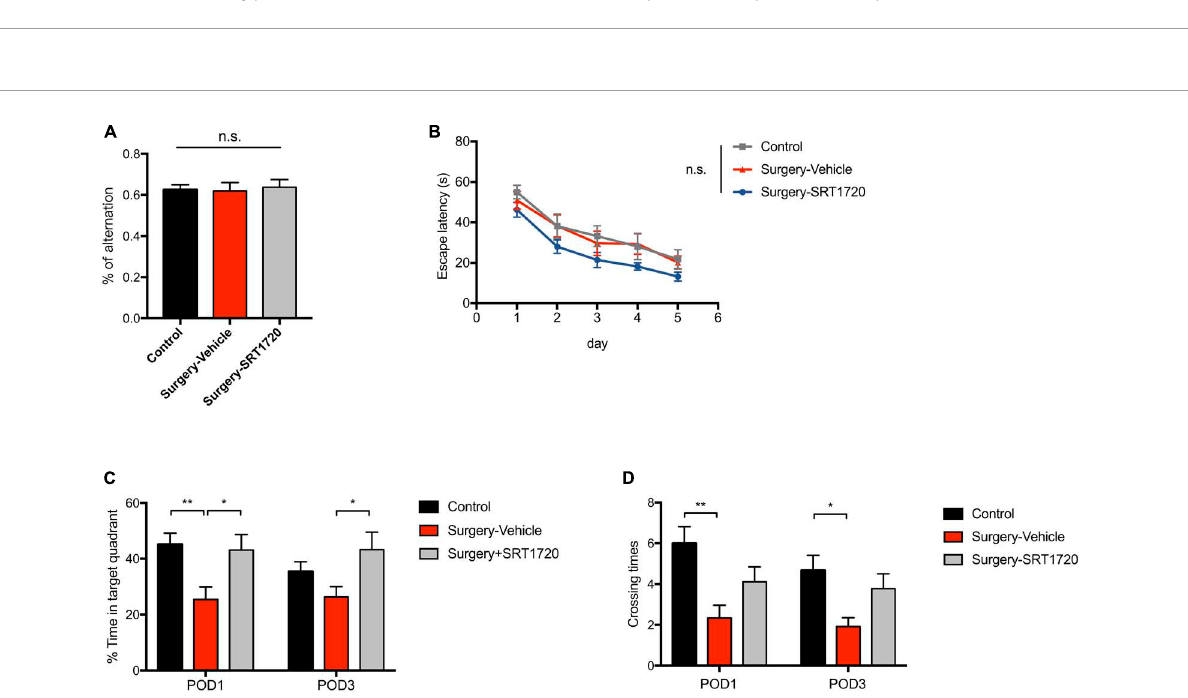
FIGURE7 SIRT1 activation overcomes loss of cognitive performance after surgery and anesthesia. (A) Y-maze performance on the third day after surgery. n = 11 for control, n = 6 for surgery-vehicle, n = 7 for surgery-SRT1720. One-way analysis of variance (ANOVA) with Tukey post-hoc test. (B) Escape latency in training trials of Morris water maze (MWM). n = 12 for control and surgery-vehicle, n = 9 for surgery-SRT1720. Two-way ANOVA with Tukey post hoc test. (C) Percentage of time spent in target quadrant in probe trials on the first and third after surgery. n = 12 for control and surgery-vehicle, n = 9 for surgery-SRT1720. Two-way ANOVA with Tukey post-hoc test (D) Crossing times of the platform area in probe trials on the first and third after surgery. n = 12 for control and surgery-vehicle, n = 9 for surgery-SRT1720. Two-way ANOVA with Bonferroni post hoc test. All data are shown as mean ± SEM. n.s., not significant; * p < 0.05; ** p < 0.01. POD, postoperative